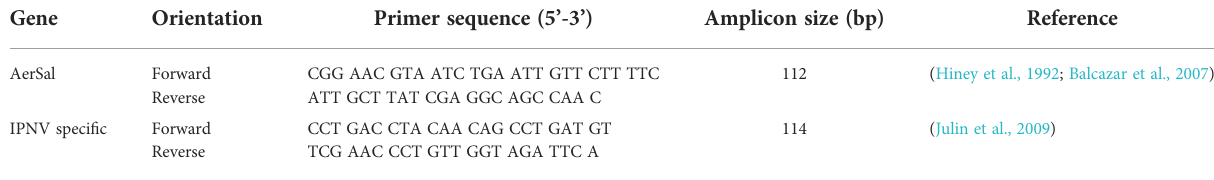
TABLE 2 List of primers used for the detection of the reference genes by RT-qPCR.